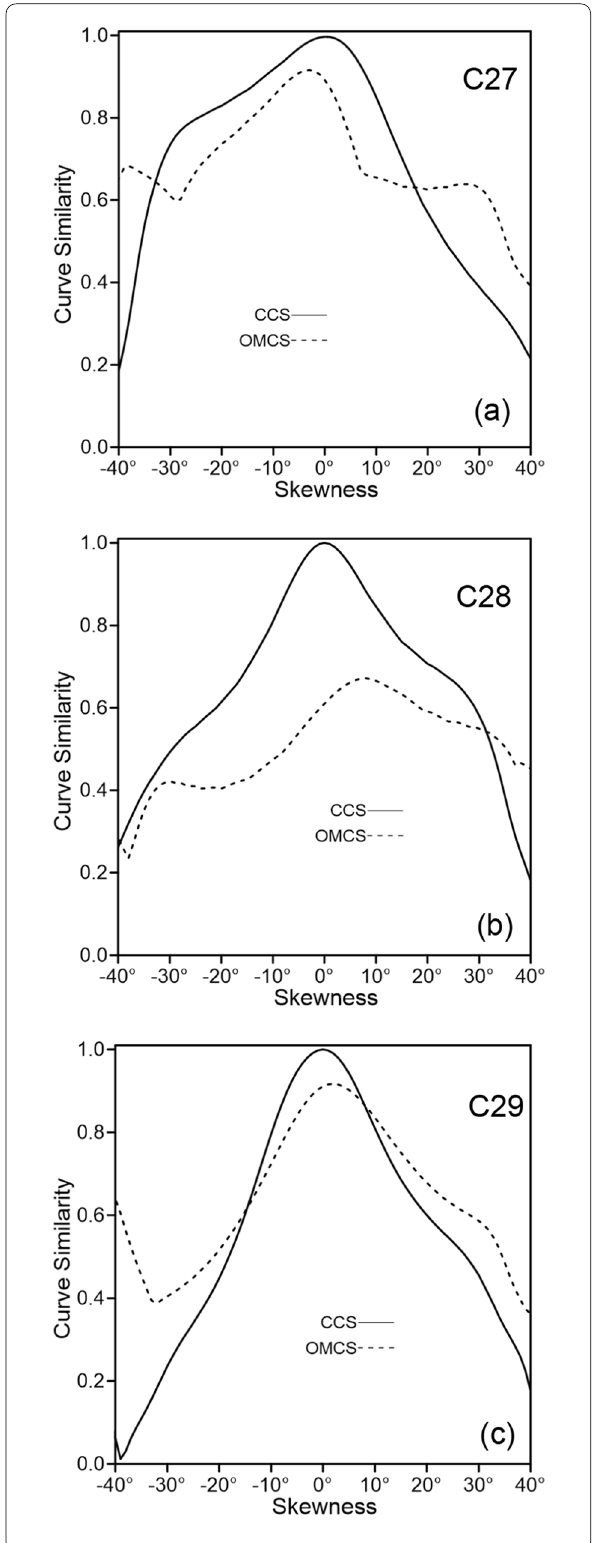
Fig. 7 The identification results of the polarity chron C27, C28 and C29 under skewness of 40° ~ 40°. a The identification results of − the polarity chron C27; b The identification results of the polarity chron C28; c The identification results of the polarity chron C29. The solid lines represent the curve similarity between the theoretical window and the observed magnetic anomalies at the position of the corresponding steps (CCS). The dashed lines represent the maximum absolute curve similarity values between the theoretical window and the observed magnetic anomalies at the position outside of the corresponding steps (OMCS)